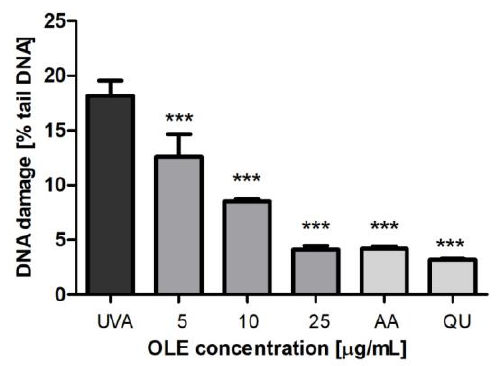
Figure 4. DNA damage, measured as the mean comet tail DNA (%) of human skin fibroblasts, untreated (UVA) or pre-incubated (24 h) with OLE (5–25 µ g/mL) or the reference antioxidants AA and QU (25 µ g/mL) followed by exposure to UVA (8 J/cm 2 ). The values of comet tail DNA were reduced by the values obtained in comet assay for non-irradiated Hs68 cells (without or with the appropriate plant compounds); the extent of this endogenous DNA damage for control (not displayed in the figure), expressed as a percentage of tail DNA, was 1.61 ± 0.32%. The number of cells in each treatment was 100. The figure shows mean results from 3 independent experiments. Error